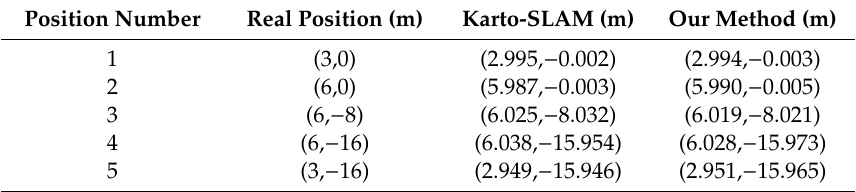
Table 2. The positioning result while Simultaneous Localization and Mapping (SLAM).